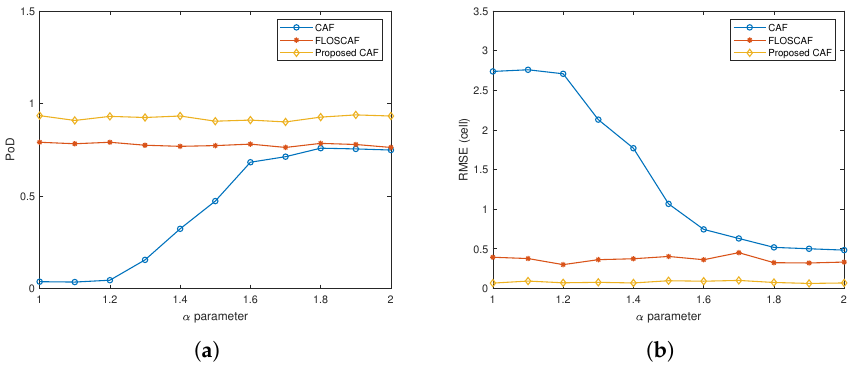
Figure 10. ( a ) PoD comparison for different algorithms (RCS = 2 m 2 ) ( b ) RMSE comparison for different algorithms (RCS = 2 m 2